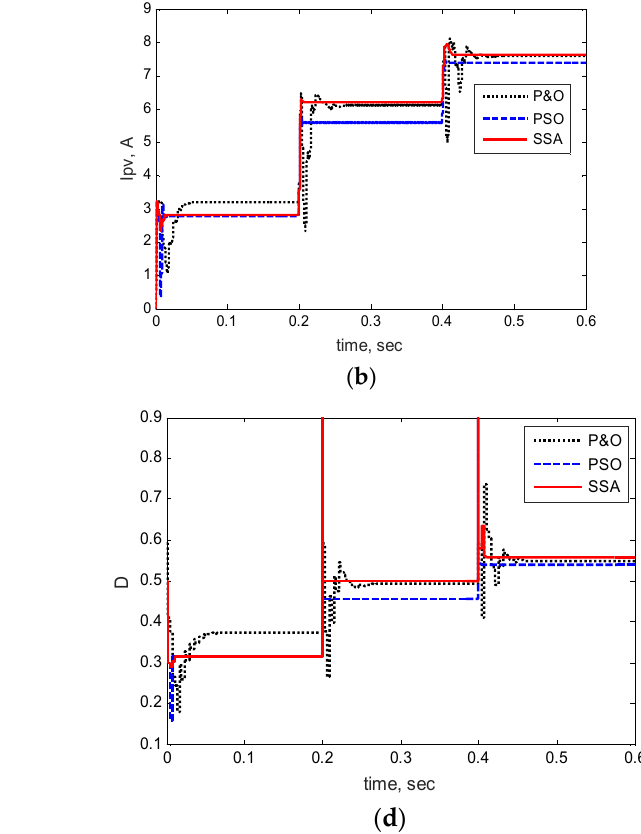
Figure 8. Photovoltaic panel tracking curves using the proposed method and P&O and PSO methods in variable radiation conditions: ( a ) Vpv, ( b ) Ipv, ( c ) Ppv, ( d ) duty cycle.